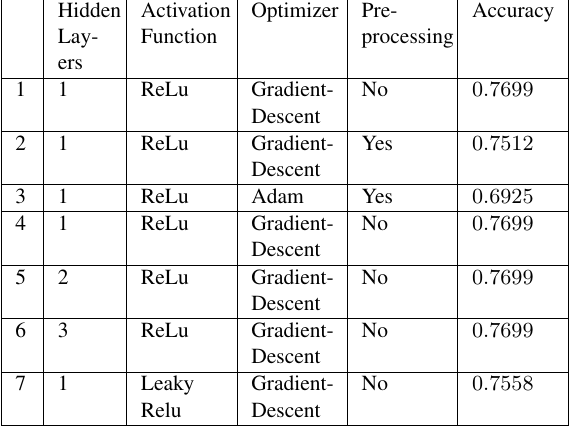
Table 1. Effect of hyper-parameters on accuracy